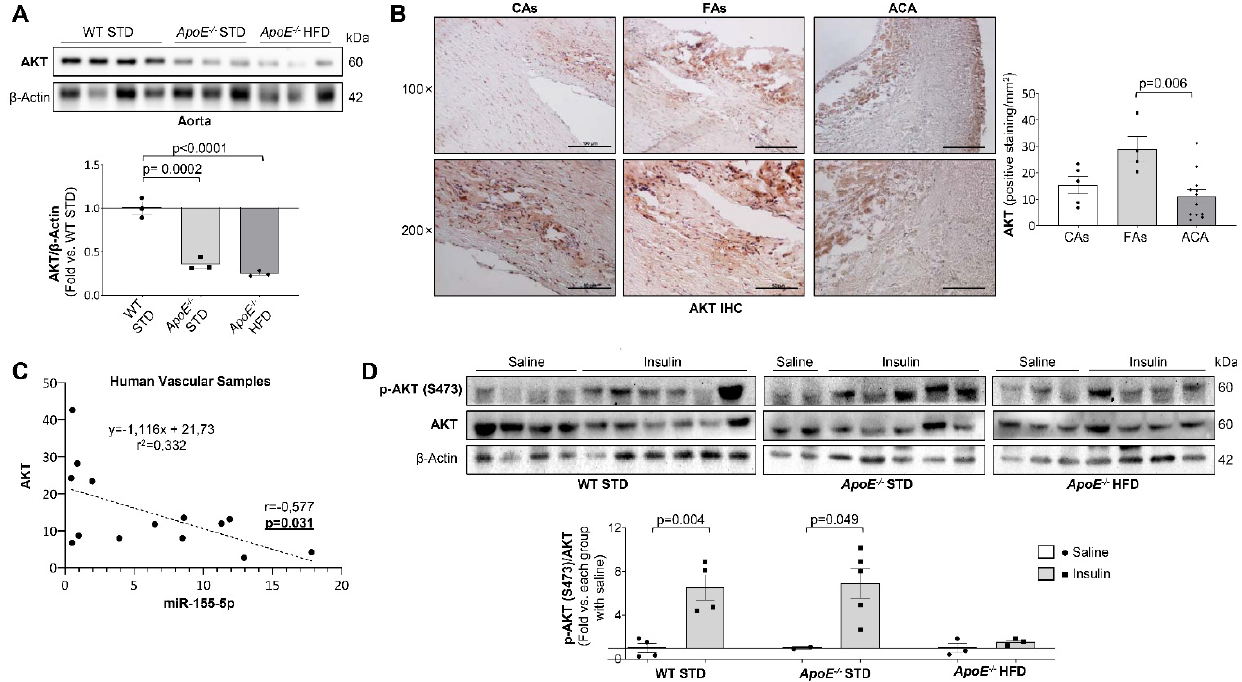
Figure 4. AKT levels are downregulated in the human samples and the mouse model where its activity is also impaired. ( A ) Representative Western blot images of the expression of AKT ( upper ) and their quantification ( lower ) in murine aorta samples. ( B ) Representative images of AKT levels measured by immunohistochemistry in the aorta and carotid human samples ( left ) and their quantification ( right ) expressed as % positive staining/mm 2 . Magnification 100 × (scale bar = 100 µ m); magnification 200 × (scale bar = 50 µ m). ( C ) Scatter plot and Spearman’s r correlation between the expression of miR-155-5p and AKT expression in human samples. ( D ) Representative Western Blot images of AKT phosphorylation ( upper ) and their quantification ( lower ) in aortas from mice subjected to in vivo insulin signaling studies. WT = Wild type group; STD = standard type diet; ApoE − / − = ApoE deficient mice; HFD = high fat diet; AKT = protein kinase B; FAs = fibrolipidic plaque; ACA = advanced carotid atherosclerotic plaque. Mouse model AKT Western blot: WT STD 18 wks ( n = 3); ApoE − / − STD 18 wks ( n = 3); ApoE − / − HFD 18 wks ( n = 3); AKT immunohistochemistry: Control subjects ( n = 5); FAs ( n = 4); ACA ( n = 12). miR-155-5p-AKT correlation ( n = 14). In vivo signalling experiments: WT STD 18 wks saline ( n = 4); WT STD 18 wks insulin ( n = 4); ApoE − / − STD 18 wks saline ( n = 2); ApoE − /